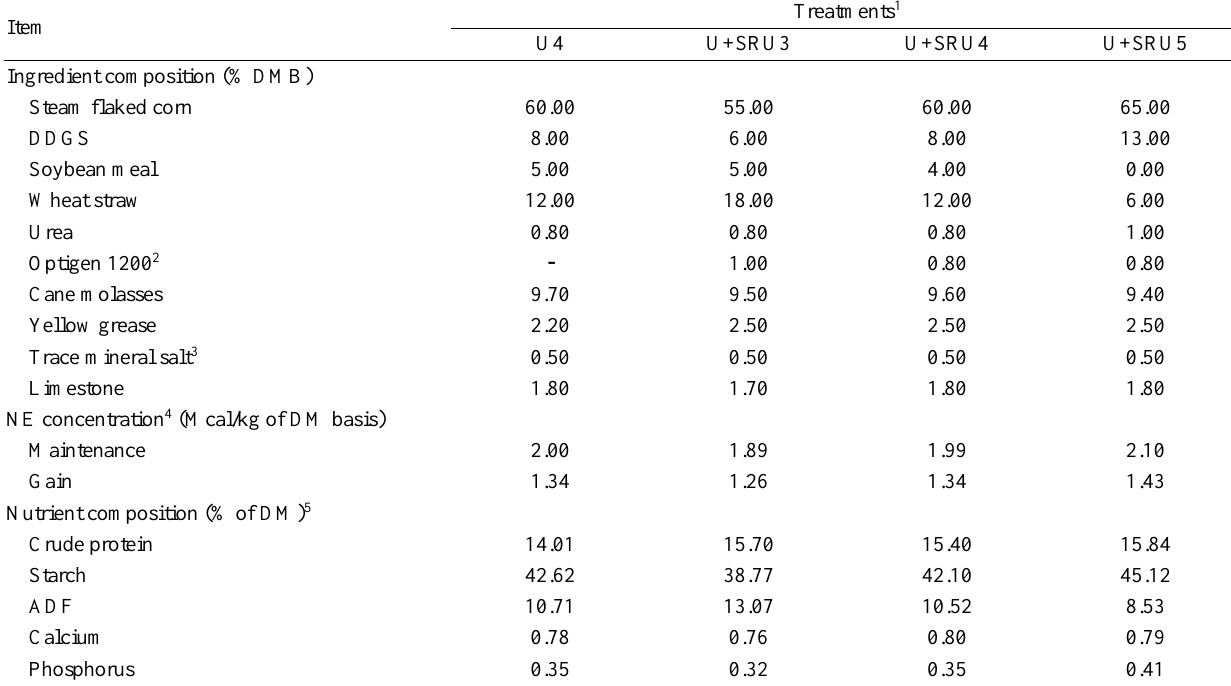
Table 1. Ingredients and composition of experimental